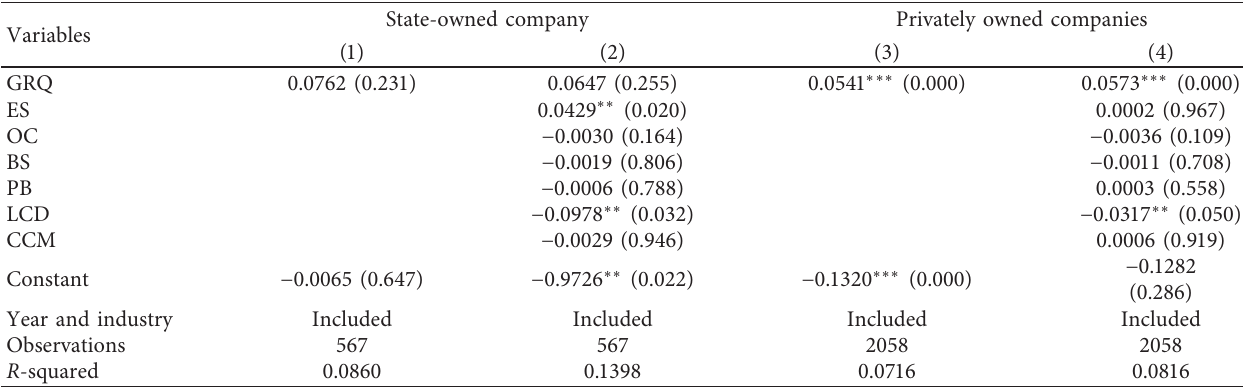
Table 10: State-owned firms versus privately owned firms: the influence of GR.